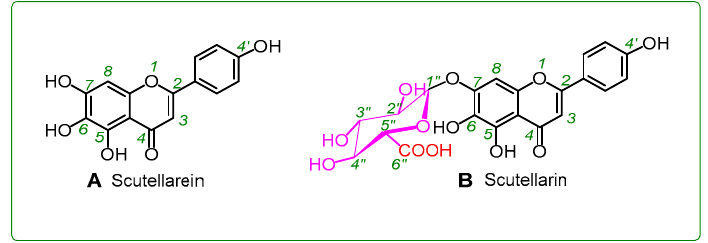
Figure 1. Structures of scutellarein ( A ) and scutellarin (i.e., scutellarein-7- O -glucuronide, B ).